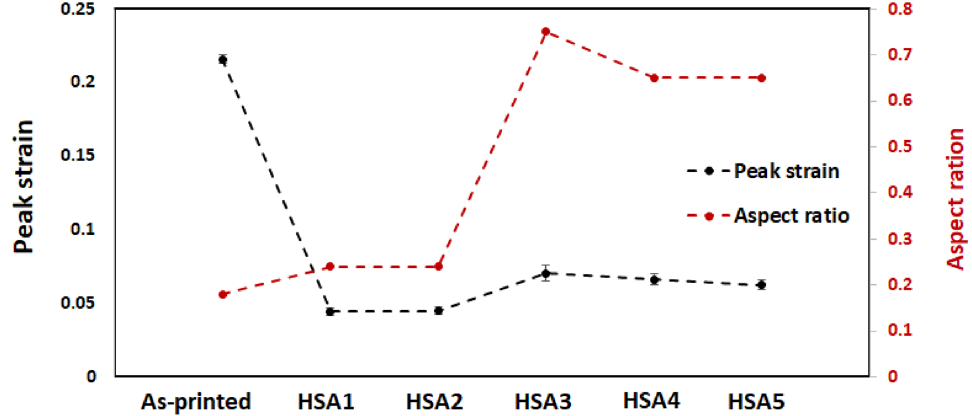
Figure 10. Evolution of the peak strain at 650 °C and aspect ratio with the heat treatment